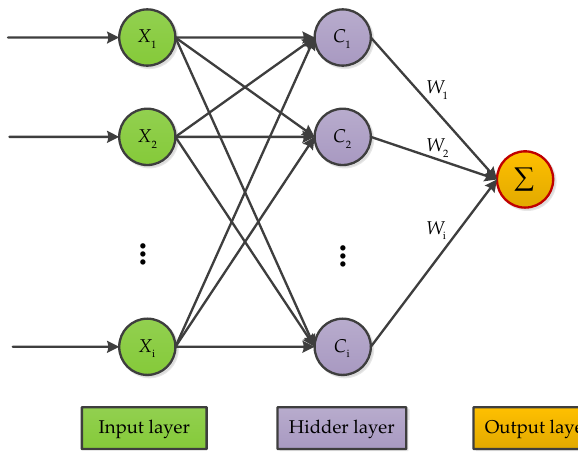
Figure 14. Radial basis function neural network structure.